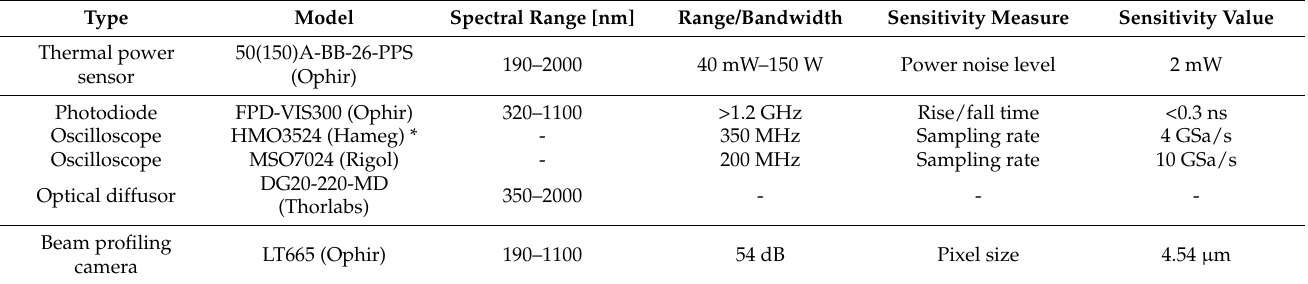
Figure 1. Laser therapy devices and sensors used in the present study to investigate laser beam parameters: ( a ) EMS laser; ( b ) K-laser; ( c ) thermal power sensor; ( d ) photodiode; ( e ) experimental setup to measure temporal profiles showing the diffusor in between the photodiode and the handpiece of the EMS laser as well as the oscilloscope (MSO7024) that recorded signals from the photodiode; ( f ) beam profiling camera. Modified from [7] with permission from the authors. Details are in the text. Table 1. Sensors for laser beam characterization used in the present study, together with their equipment and selected sensitivity